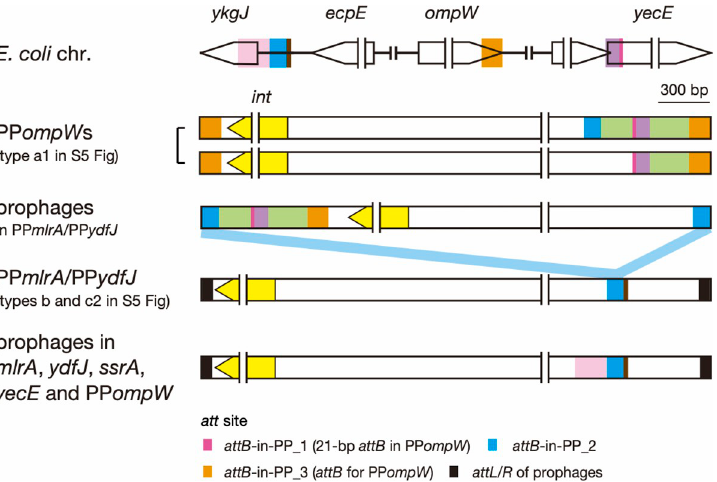
Fig 5. Locations of the attB -in-PP sequences in prophages and the prophage genome regions homologous to E . coli chromosome regions. Three loci in the E . coli chromosome showing sequence homology to three identified attB - in-PP sequences and their flanking sequences are shown at the top. The left- and right-end regions of representative prophages that contained the att -in-PP sequences are shown below. Homologous sequences are indicated by the same color. The color used for each attB -in-PP sequence is the same as that used in Figs 4 and S5. See these figures for the details of “PP ompW s” and “prophages in PP mlrA /PP ydfJ ”and S9 Fig for information on the prophages in mlrA , ydfJ , ssrA , and yecE and PP ompW . Alignments of the attB -in-PP_1 and attB -in-PP_2 sequences and their flanking sequences with corresponding chromosome sequences are shown in S8 and S9 Figs, respectively.